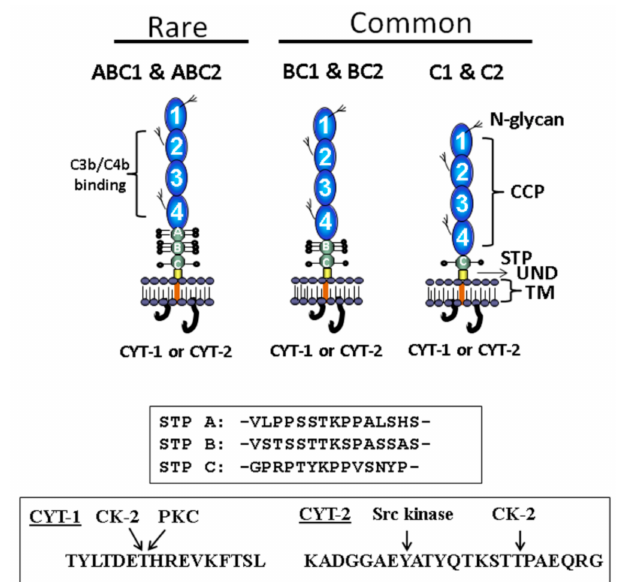
Figure 1. CD46 (membrane cofactor protein; MCP) is a widely expressed, alternatively spliced complement regulatory protein whose structure is dominated by four complement control protein modules (CCPs). CCPs 2–4 house the main sites for C3b and C4b interactions. CCPs 1, 2 and 4 feature N -glycans. Alternative splicing of the STP region (enriched in serines, threonines and prolines, and a site of variable levels for O -glycosylation) and of the cytoplasmic tails (CYT-1 or CYT-2, which have distinct signaling motifs) generates four common isoforms co-expressed to variable levels on most cells. These are called BC1, BC2, C1 and C2. Rarer isoforms also exist. UND, undefined juxtamembraneous